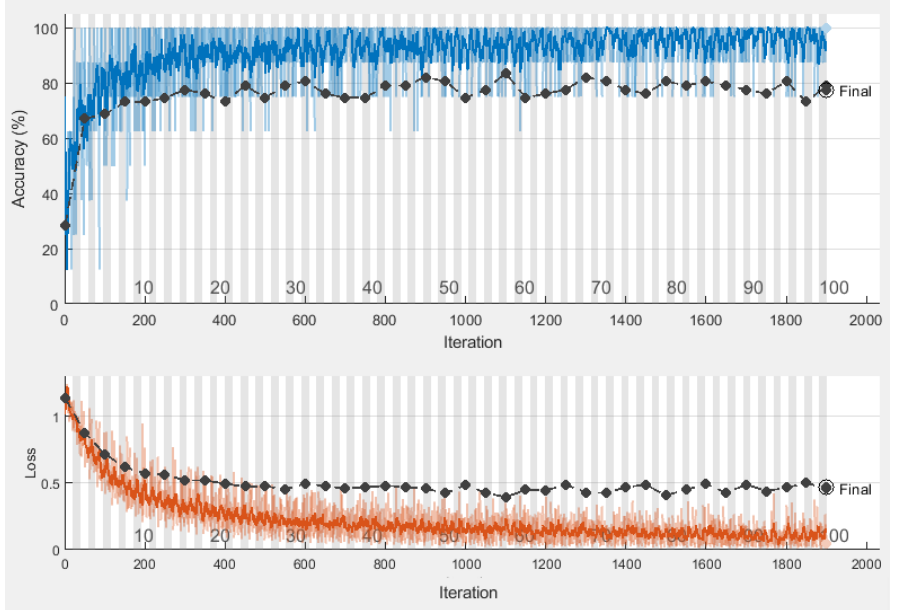
Figure 5. Proposed CNN training and validation